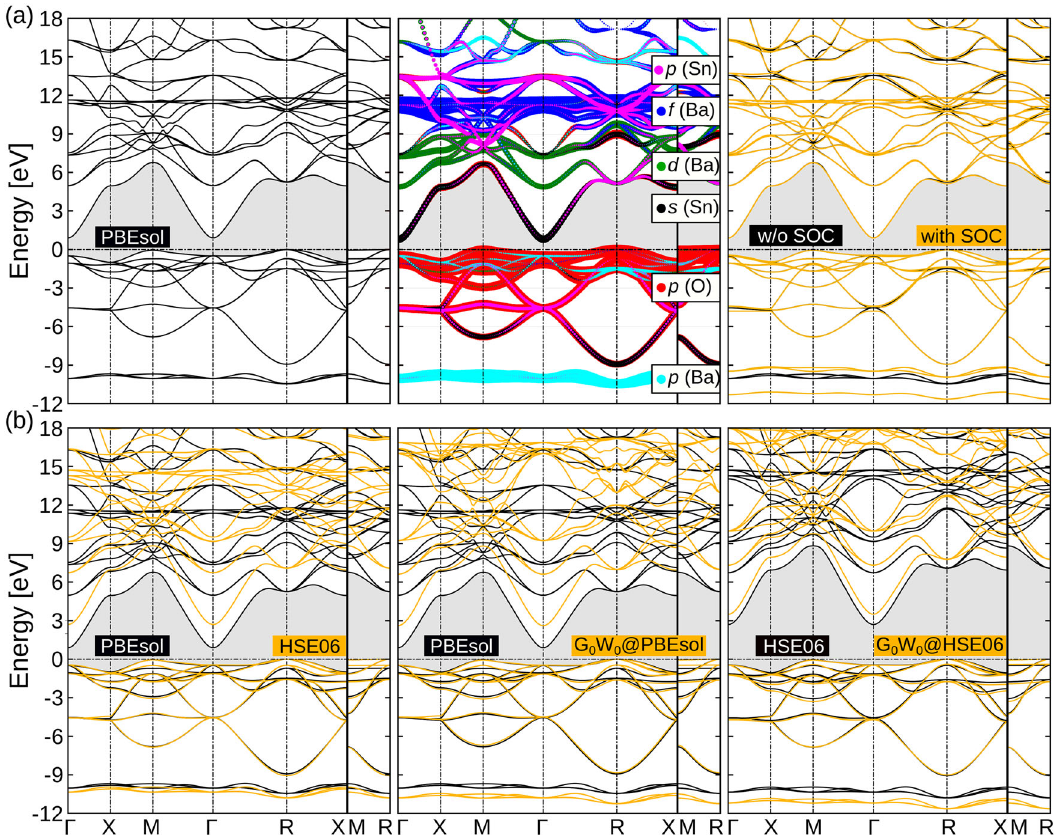
Fig. 2 Band structure of cubic BaSnO 3 . a Result of PBEsol, where in the middle panel the band characters are highlighted; in the right panel, the effect of spin – orbit coupling, SOC, is shown. b From left to right: comparison of HSE06 with PBEsol; G 0 W 0 @PBEsol; G 0 W 0 @HSE06. The valence band maximum is set to